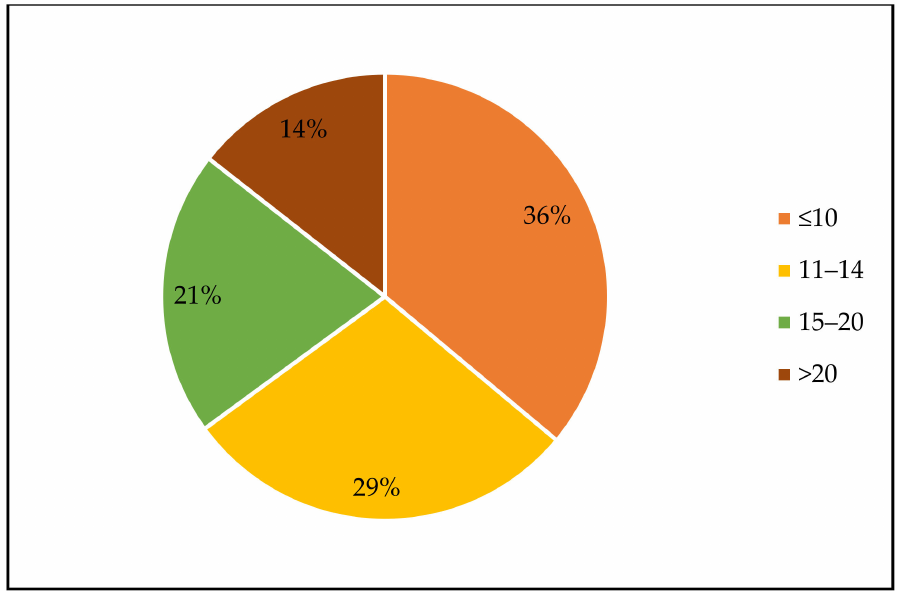
Figure 5. Number of experiments carried out in the surveyed articles ( n =